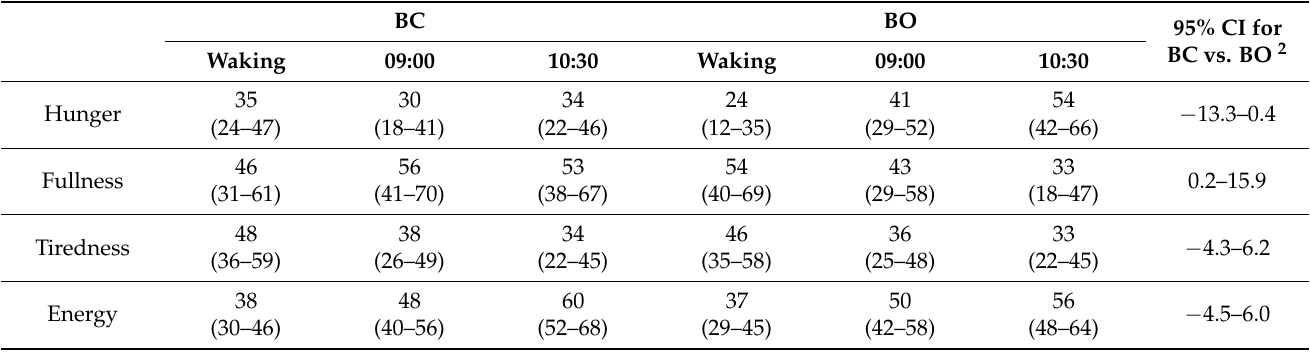
Table 5. Perceived appetite, tiredness, and energy levels (measured in mm out of 100) of adolescent girls who participated in the randomised crossover trial comparing seven days of breakfast consumption (BC) with seven days of breakfast omission (BO) 1